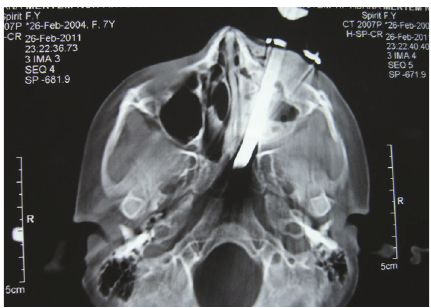
Figure 3: Foreign body visualised on CT at the time of admission.